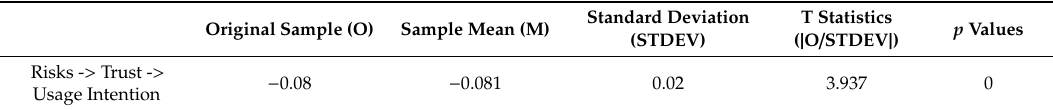
Table 8. Indirect e ff